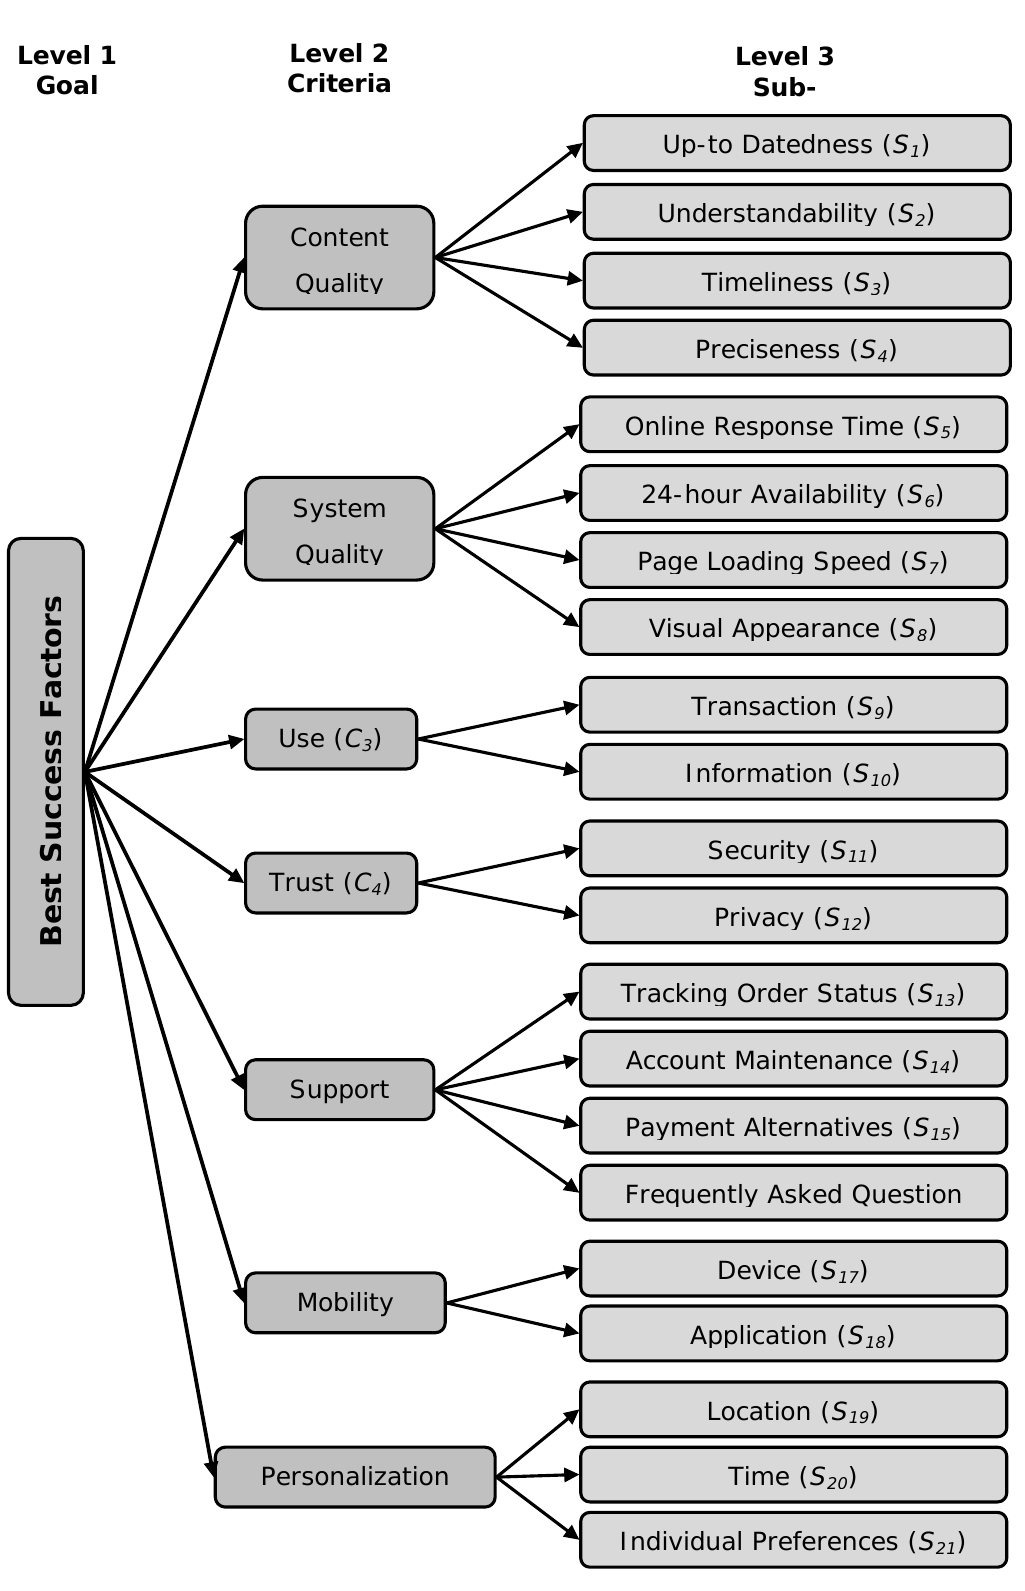
Figure 3. “Objective hierarchies for the evaluation of mobile commerce success